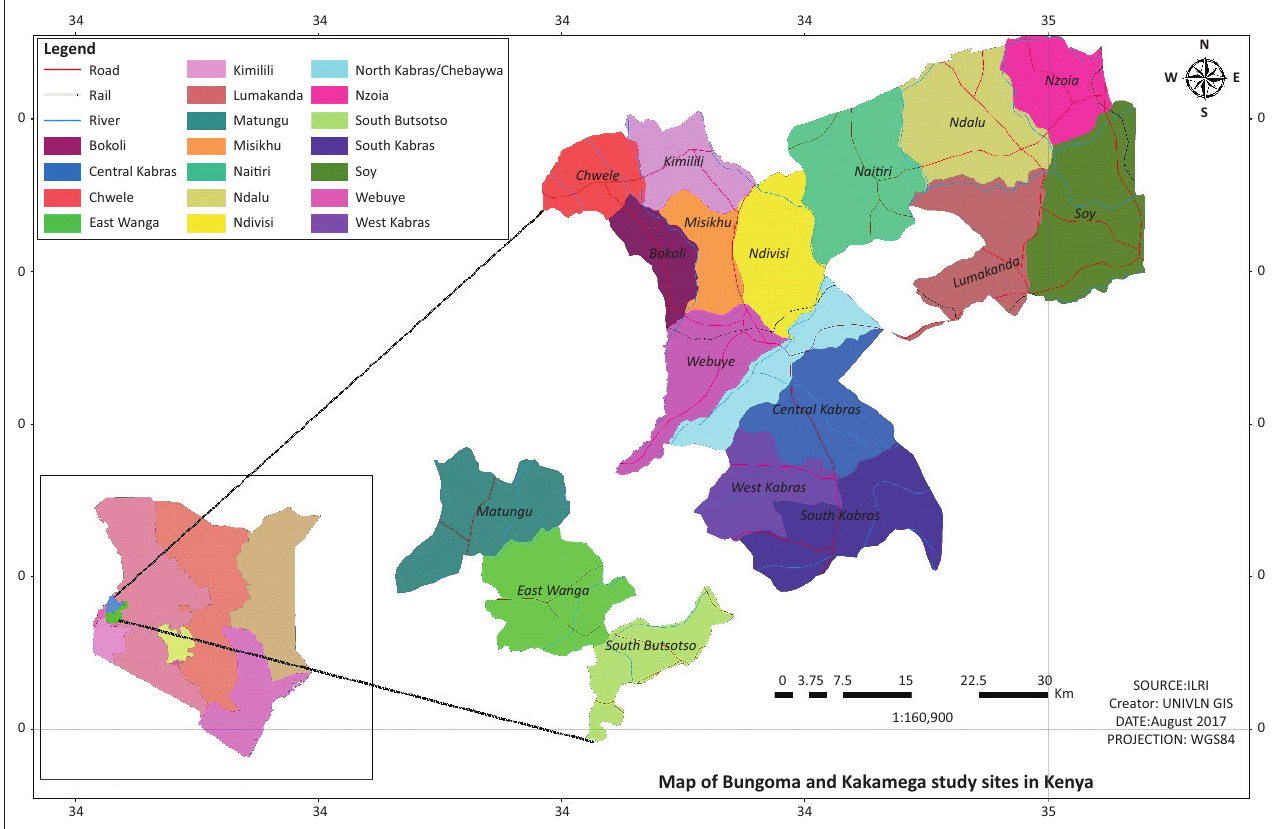
FIGURE 2: Map of study area (GIS